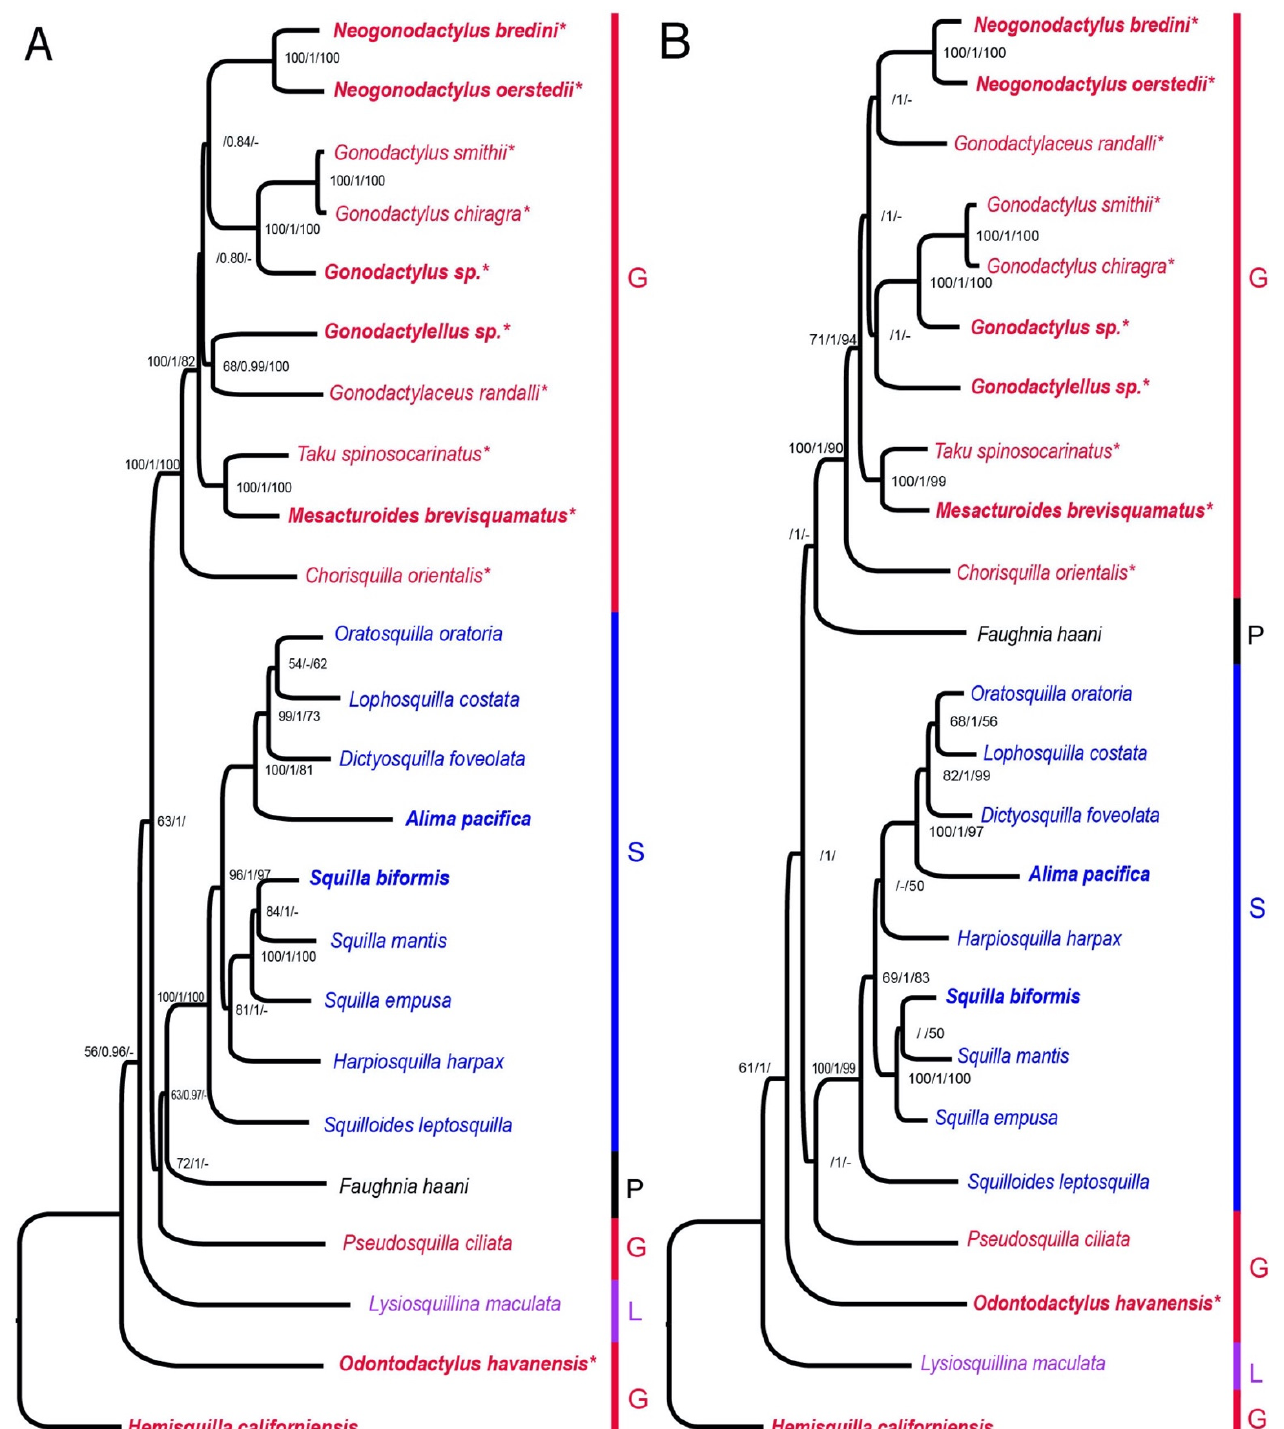
Figure 4. Stomatopoda phylogeny based on the concatenated mitochondrial genes and 18S rRNA sequences; rooted with Hemisquilla californiensis . ( A ) Maximum likelihood tree from the nucleotide dataset (HemiNuc). ( B ) Maximum likelihood tree from the mixed amino acid and nucleotide dataset (HemiAA). Newly sequenced species are in bold. Each superfamily is coded by color of the taxon name. Superfamily abbreviations are G: Gonodactyloidea, L: Lysiosquilloidea, S: Squilloidea, P: Parasquilloidea. Asterisks (*) after the taxon name denote smashers. Values at the nodes represent the bootstrap values of ML and MP and the posterior probability of BI in the format (ML/BI/MP). Values not listed were below 50 for bootstrap or below 0.70 for posterior probabilities. Hyphens (-) represent nodes not recovered by the MP or BI analyses.